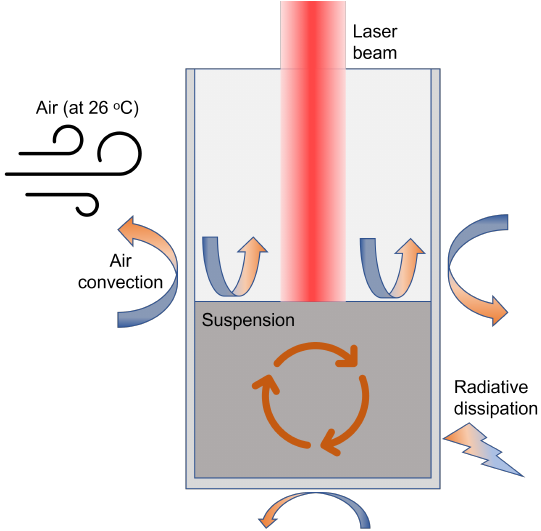
Figure 2. Heat dissipation methods implemented in the model.